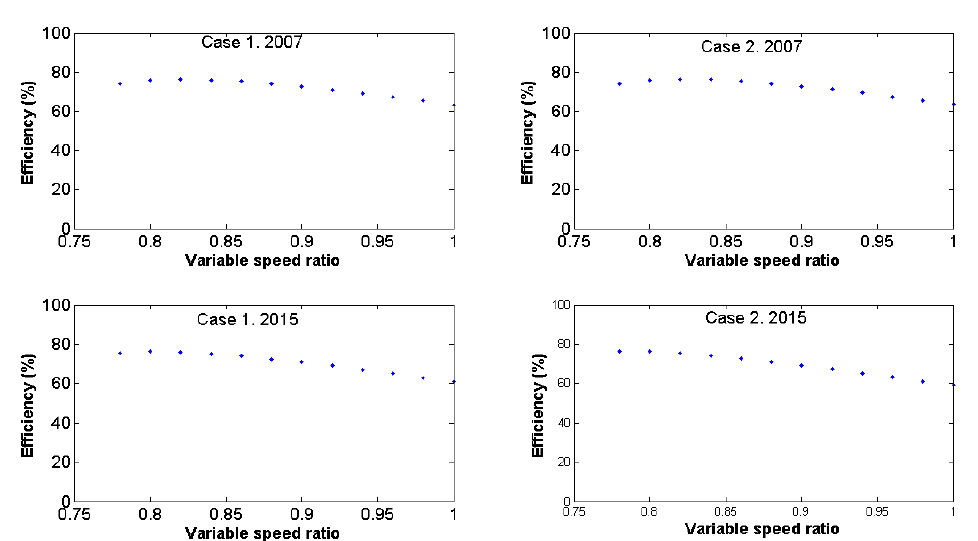
Figure 12. Operating point at fixed speed in WUA B for Case 2 in 2007 ( a ) and 2015 ( b ) irrigation seasons.